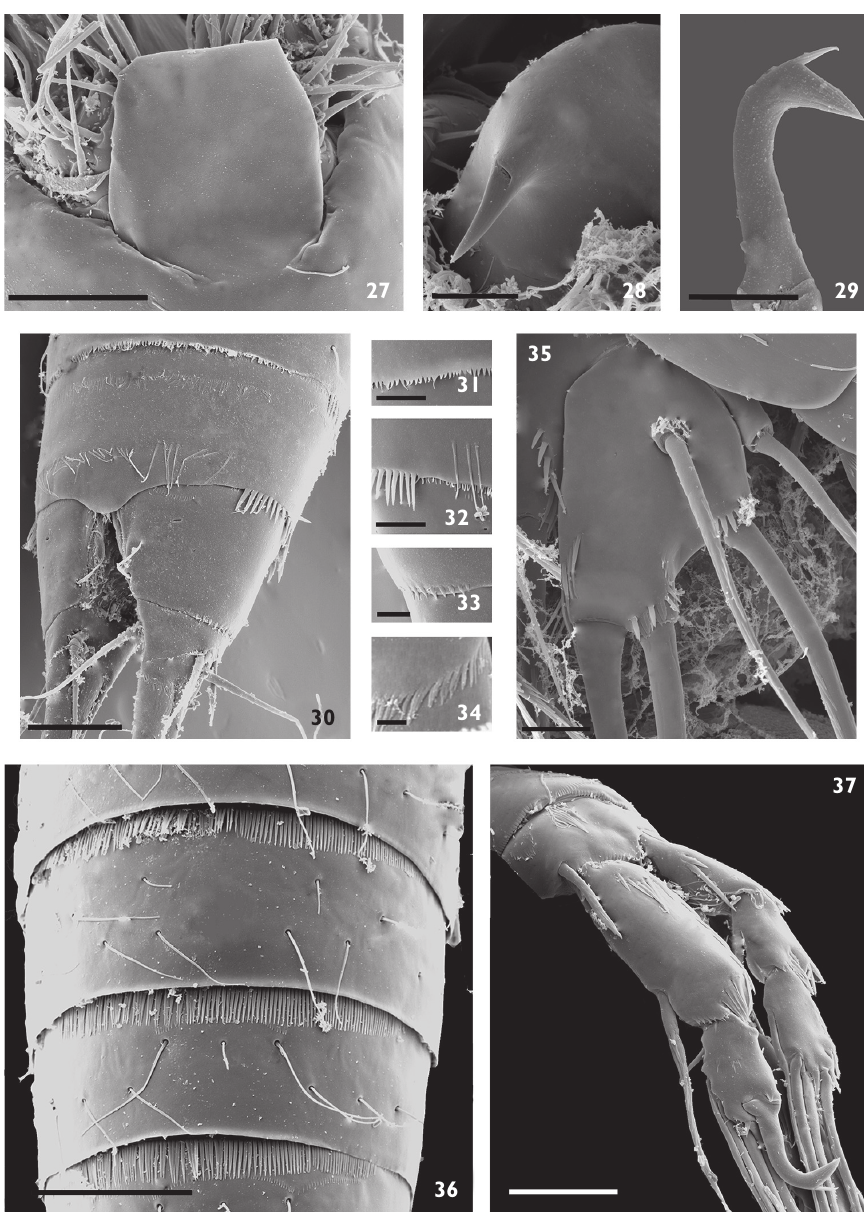
Figures 27-37. Chaulionyx paivacarvalhoi gen. et sp. n. Scanning electron micrographs ( ♀ : 27-35 ; ♂ : 36-37 ): 27 rostrum, dorsal 28 labrum, anterior 29 bifi d outer spine on P1 enp-2 30 second abdominal somite (posterior margin), third abdominal somite, anal somite and caudal rami, dorsolateral 31 detail of serrate posterior margin of second abdominal somite 32 detail of posterior margin of third abdominal somite 33 posterior margin of anal somite 34 posterior margin of caudal ramus showing dorsal semi- circular serrate extension 35 P5, anterior 36 prosomal ornamentation, dorsal 37 P1 endopod, anterior. Scale bars: 1 μm ( 34 ), 2.5 μm ( 33 ), 5 μm ( 28-29 , 31-32 , 35 ), 10 μm 27 ( 30 , 37 ), 20 μm ( 36